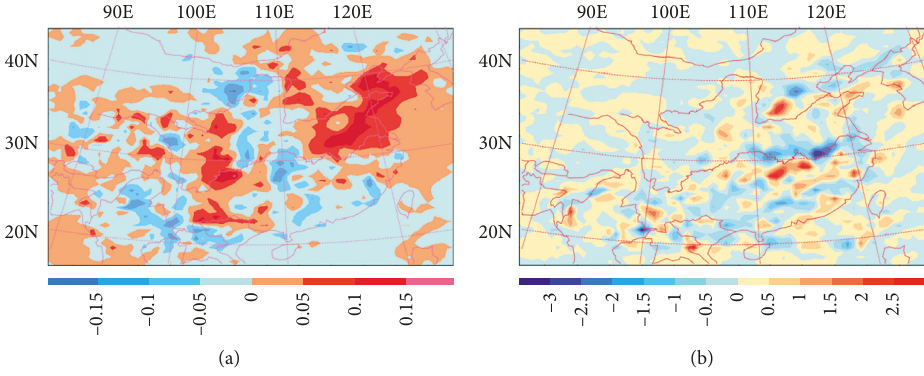
Figure 9: Annual average climate effects of BC aerosols. (a) Temperature (K). (b) Precipitation (mm/d). Table 1: Regional average direct radiative forcing of BC aerosols and the climate effects. All-sky radiation at the top of Clear-sky radiation at the top atmosphere (W/m 2 )